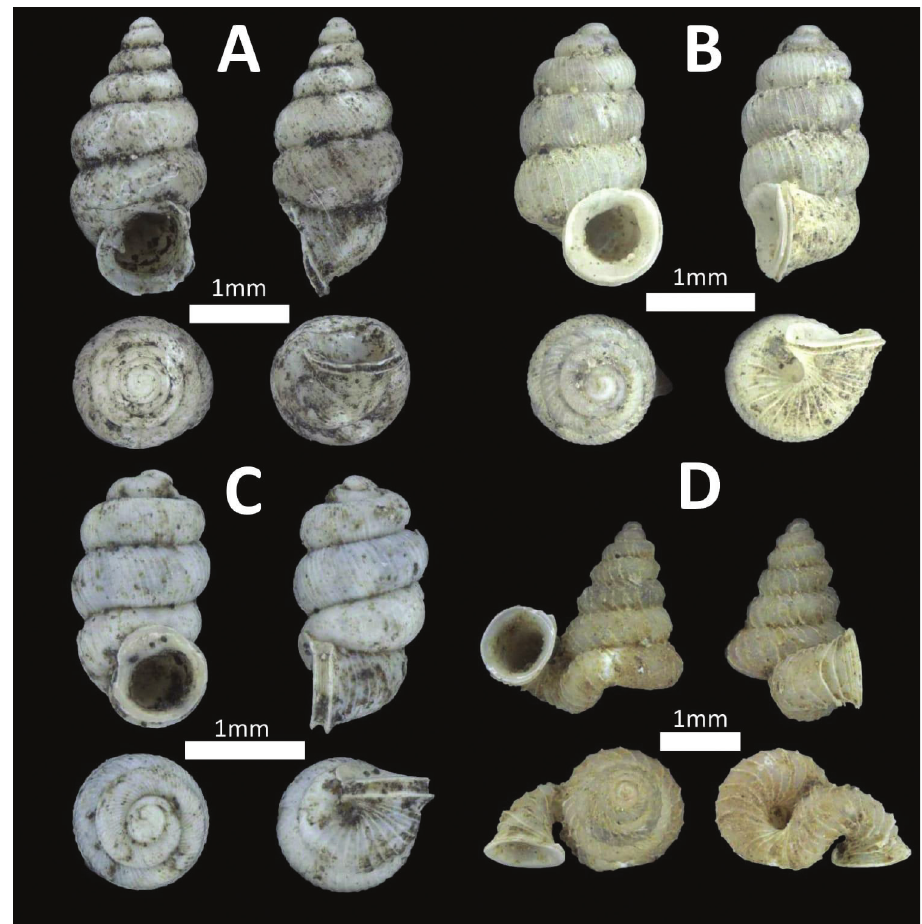
Figure 5. Family Diplommatinidae. A Diplommatina recta (BOR/MOL 12297) B Arinia borneensis (BOR/MOL 12053) C Arinia sp. (BOR/MOL 12252) D Plectostoma jucundum (BOR/MOL 7179).